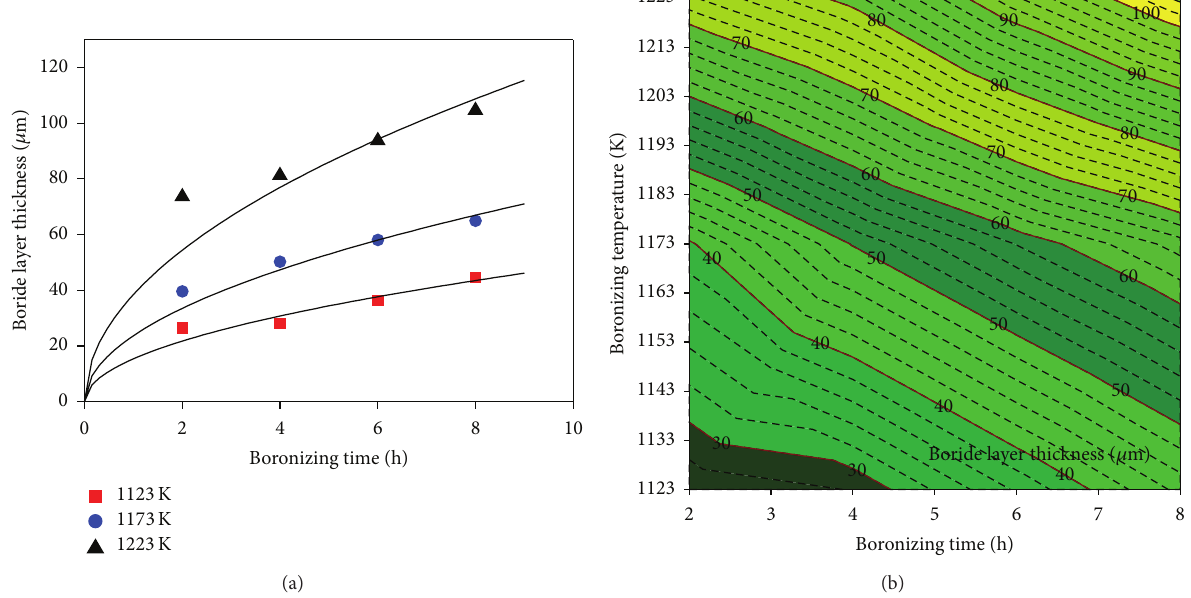
Figure 4: (a) Boride layer thickness formed on GCI as a function time and temperature; (b) the contour diagram of boride layer thickness of boronized GCI.